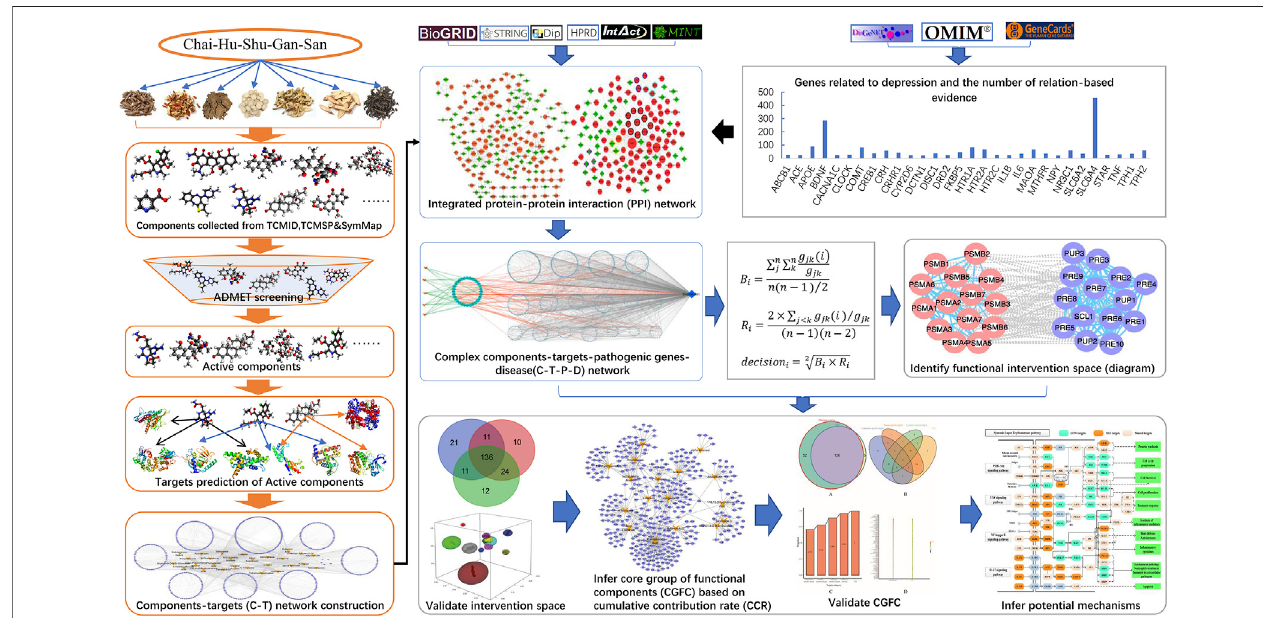
FIGURE 1 | The work scheme of our network pharmacology approach. Firstly, the pathogenic genes of depression, components of CHSGS and protein – protein interactions (PPI) were extracted from the published literature reports and databases. Previously proposed ADMET models were used to select potential active components. Targets of these active components were predicted to establish the C-T network. Then, the pathogenic genes with frequency of evidence and active components-targets network were mapped to the integrated PPI to construct components-targets-pathogenic genes-disease (CTPD) network. This complex network contains a large amount of redundant information. In order to obtain the most useful treatment information, fi nd out the parts with greater contribution to intervention and have higher correlation between targetsof active components, we developed a new node importance characterization method. Based on this method, we select the effective intervention space from the CTPD network. In the effective intervention space, we predicted CGFC by using the CCC model. Finally, the CGFC was used to infer the underlying molecular mechanism of CHSGS in treating depression.